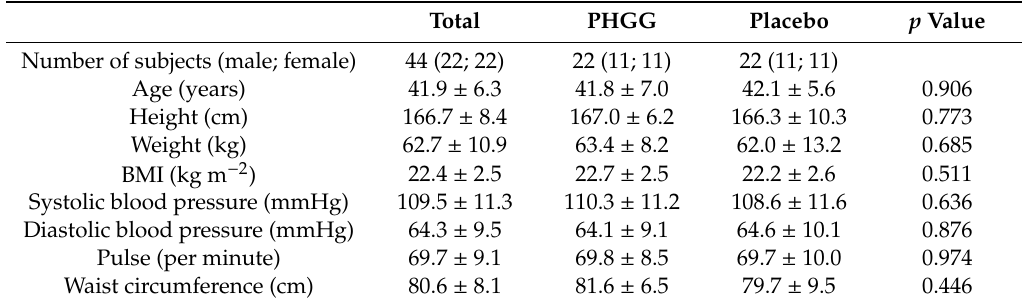
Table 1. Background of the subjects at